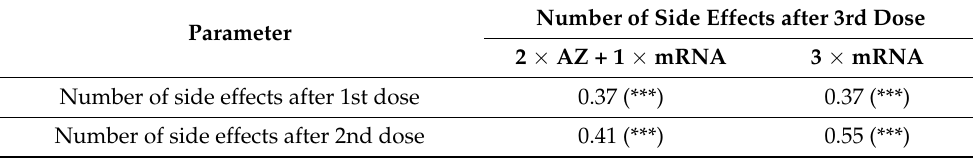
Figure 1. ( A – C ) Side effects reported in both groups after each vaccine dose. Asterisks indicate statistically significant differences in frequency between the groups (* p < 0.05; ** p < 0.01; *** p < 0.001; ns–not significant, p > 0.05); ( D ) The number of side effects (median and interquartile range) after each vaccine dose in the homologous and heterologous groups. Different capital letters indicate a significant difference between particular doses in the 2 × AZ + 1 × mRNA group, while different small letters indicate a significant difference between particular doses in the 3 × mRNA group (Kruskal–Wallis ANOVA with Dunn’s post-hoc test). Table 2. The Spearman’s correlation coefficient calculated between a number of side effects observed after particular vaccine doses in the 2 × AZ + 1 × mRNA and 3 × mRNA